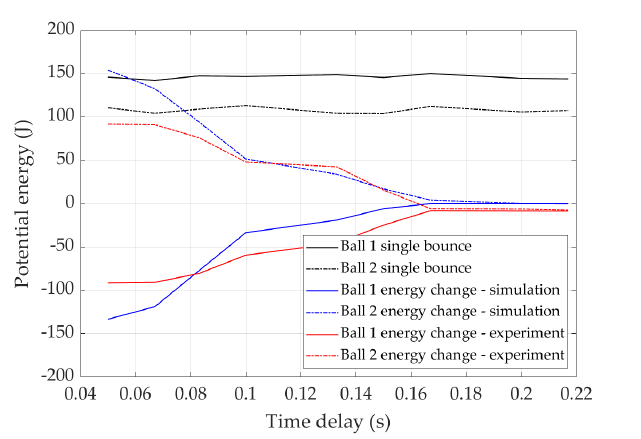
Figure 15. Potential energy comparison of double bounce and single